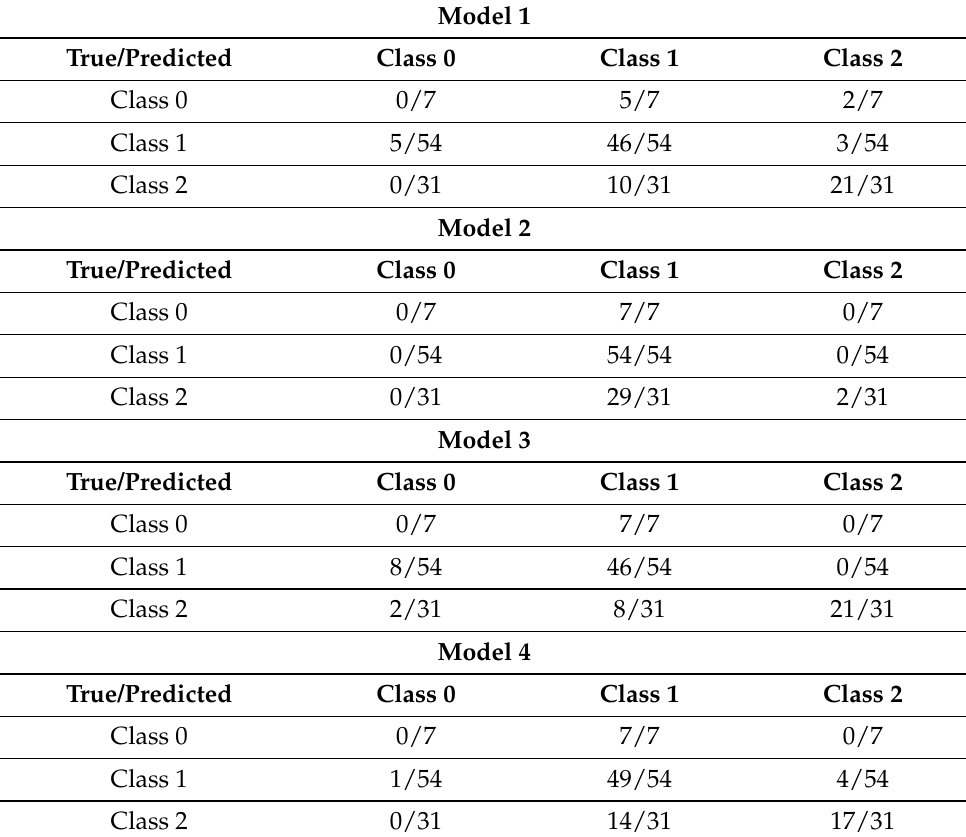
Table 19. Confusion matrices for models